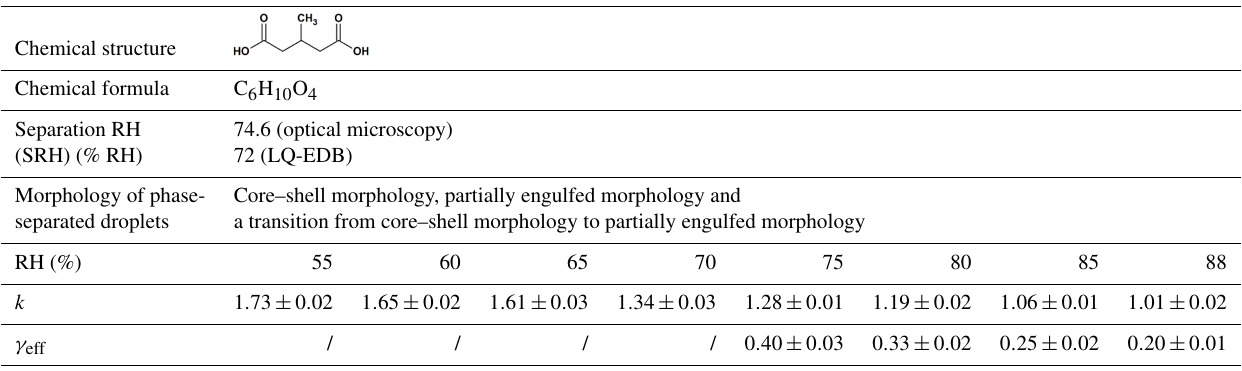
Table 1. Chemical structure, effective heterogeneous OH rate constant, and effective uptake coefficient of aqueous droplets containing 3- MGA and ammonium sulfate (AS) in an organic-to-inorganic dry mass ratio (OIR) = 1 at different RH at